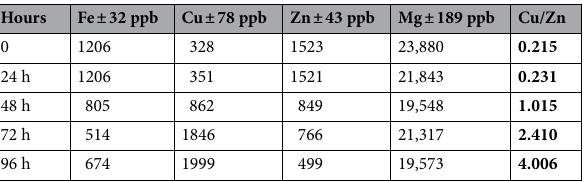
Table 2. LIBS determined concentrations of Cu, Zn, Mg and Fe in malarial blood. Significant values are in bold.